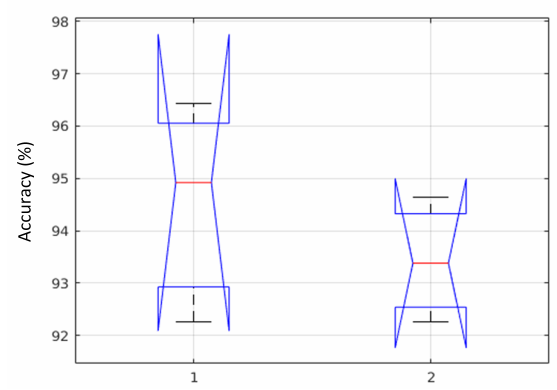
Figure 10. Box-plot of accuracy values for selected classifiers (1:SVM-C, 2:SVM-Q).